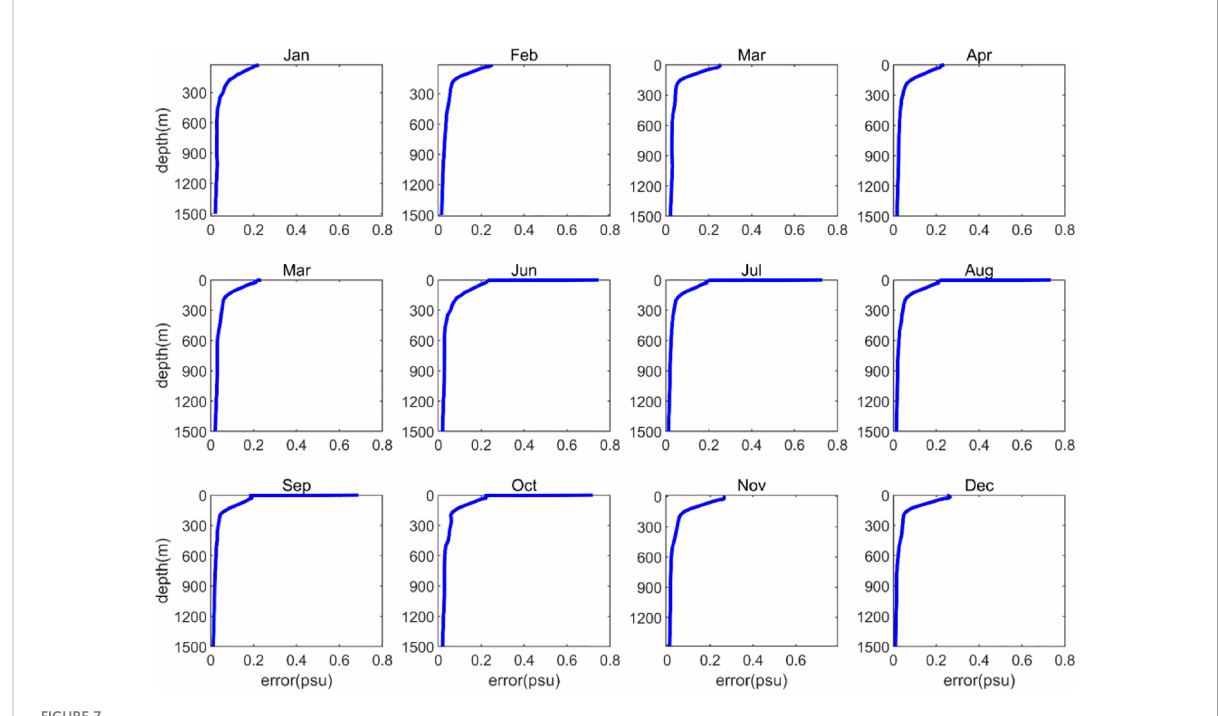
FIGURE 7 Vertical distribution of expanded salinity fi eld monthly errors in the northern South China Sea.